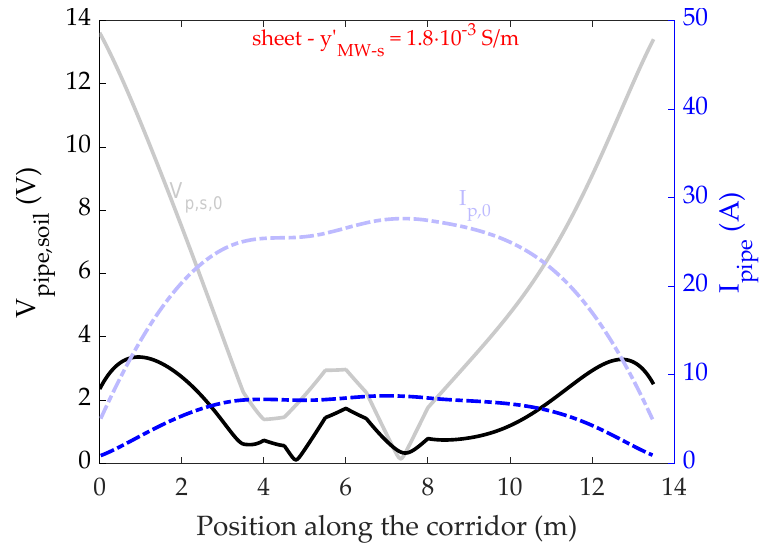
Figure 6. Magnitude of induced pipe-to-soil voltage and longitudinal pipe current along the corridor, when a single conductive sheet is buried above the